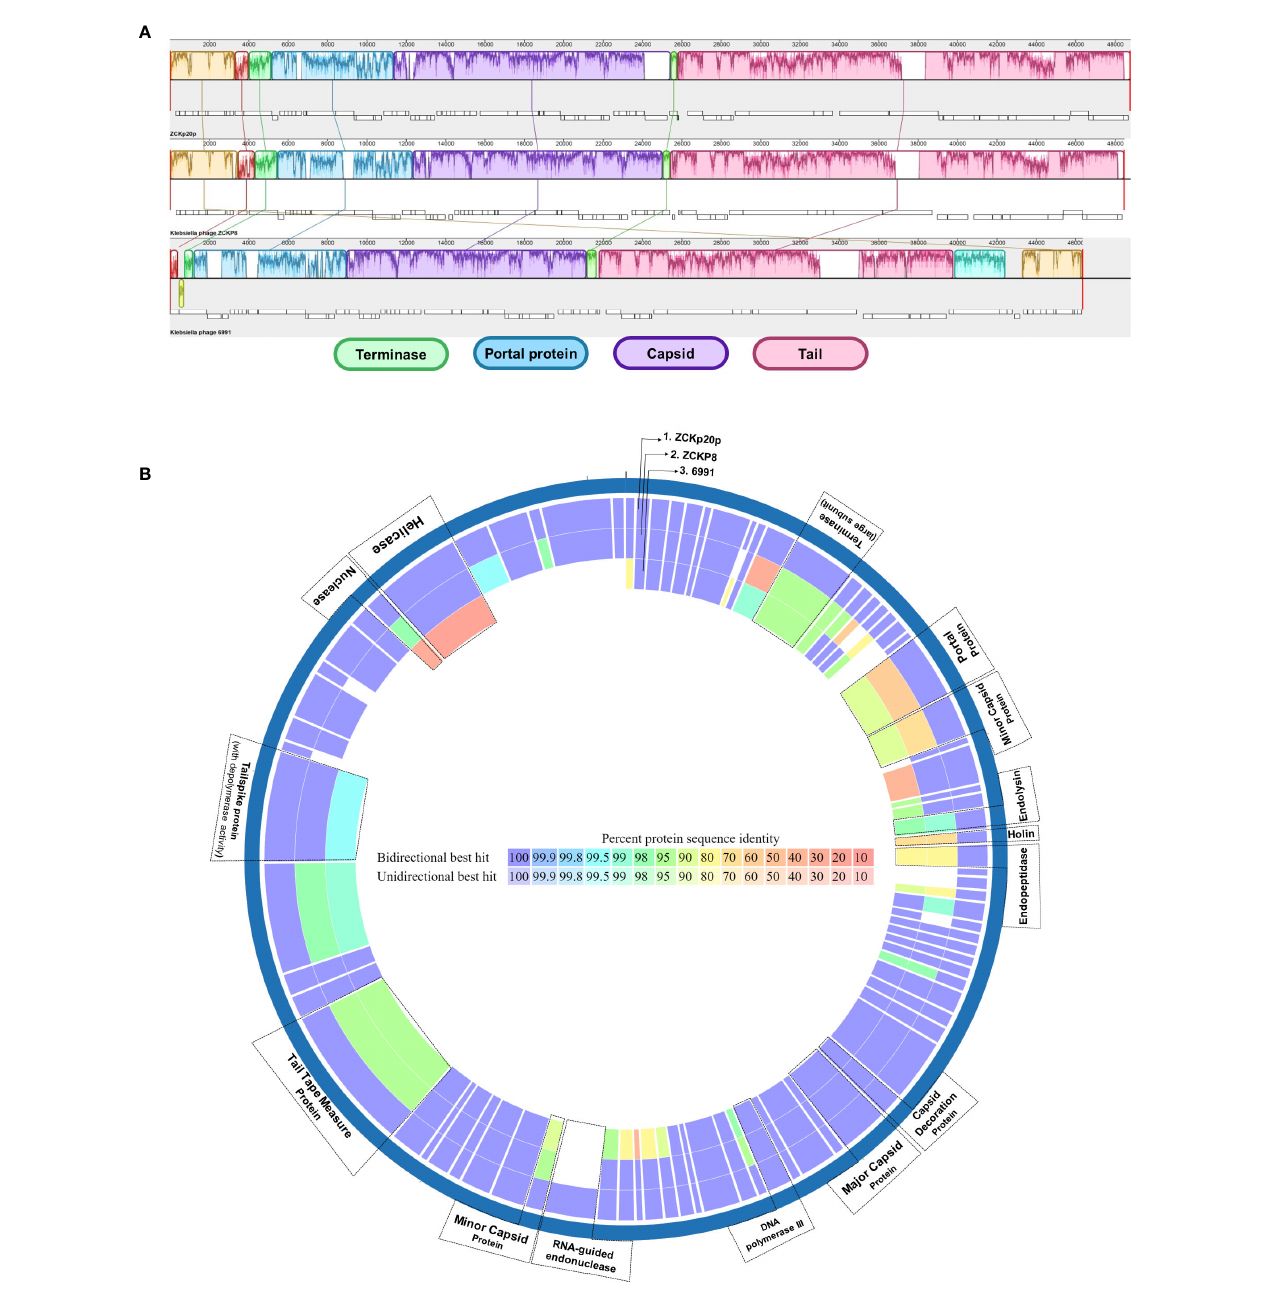
FIGURE 9 Comparative genomic map of phage vB_Kpn_ZCKp20p and closely related phages. (A) Progressive MAUVE alignment of phage vB_Kpn_ZCKp20p and closely related phages Klebsiella phages ZCKP8 and 6991: genomic regions with homology are represented in the same colors. (B) Comparative circular map of protein-coding genes of phage vB_Kpn_ZCKp20p and closely related phages ( Klebsiella phages ZCKP8 and 6991) on